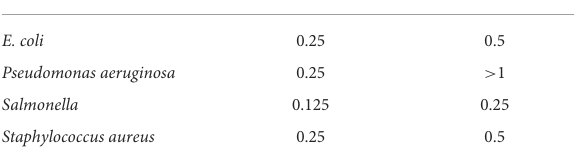
TABLE 1 The antibacterial effect of cinnamaldehyde in vapor